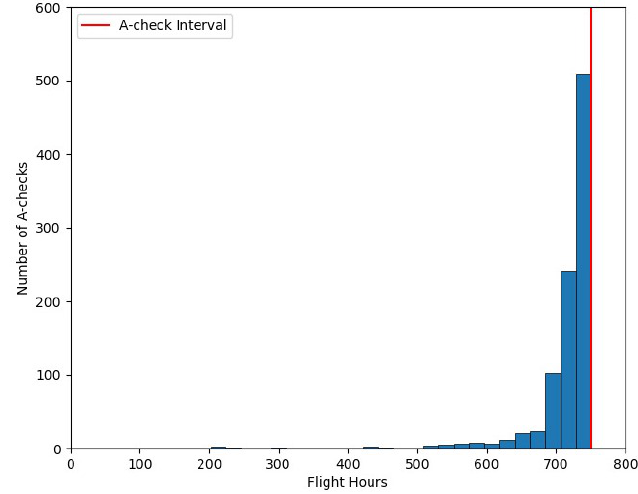
Figure 3. Distribution of A-check usages.